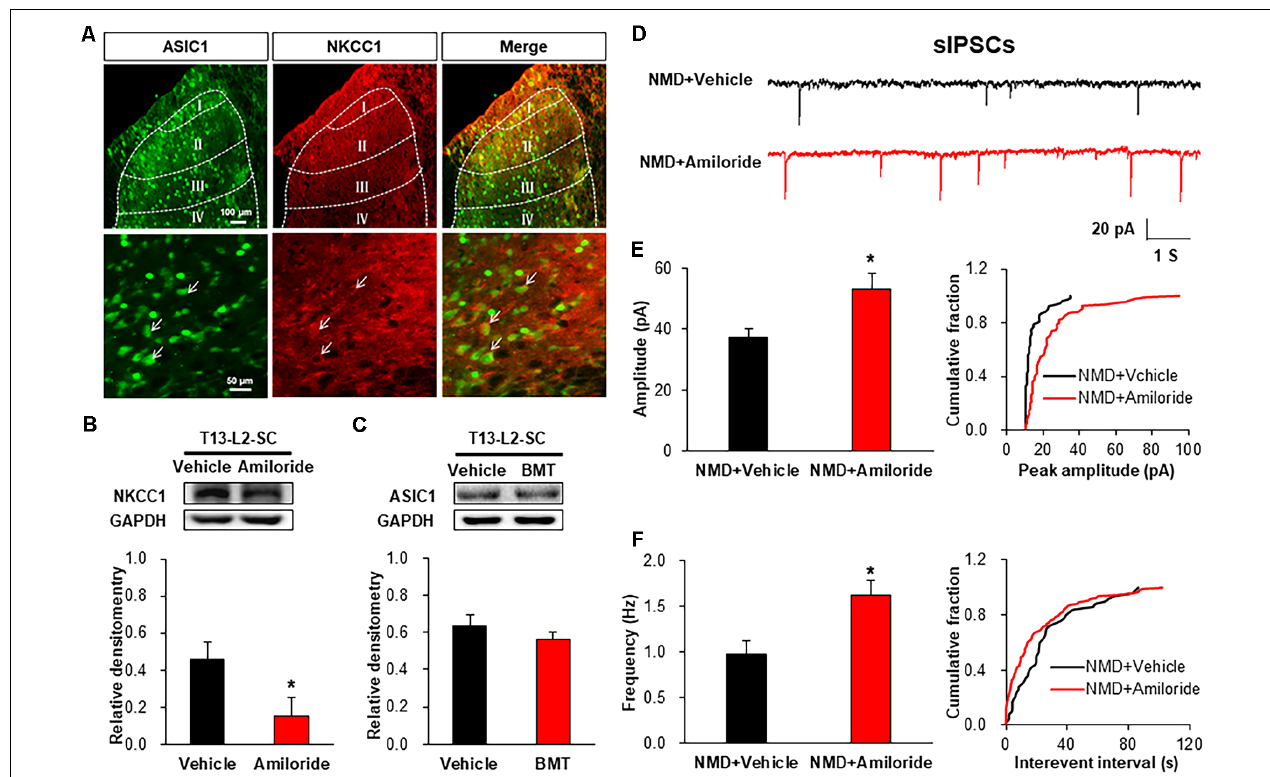
FIGURE 7 | Interaction of ASIC1 and NKCC1. (A) ASIC1 and NKCC1 were co-located in the spinal dorsal horn neurons. (B) Expression of NKCC1 in the spinal dorsal horn after intrathecal injection of Amiloride in NMD rats (* P < 0.05, n = 6 rats for NMD + DMSO group and n = 5 rats for NMD+Amiloride group, two-sample t -test). (C) Expression of ASIC1 in the spinal dorsal horn after intrathecal injection of BMT in NMD rats ( P > 0.05, n = 4 rats for each group, two-sample t -test). (D) Representative traces of sIPSCs recorded in spinal dorsal horn neurons of NMD rats after injection of Amiloride and DMSO. (E) Bar plots and cumulative probability distributions of the amplitude of sIPSCs recorded in spinal dorsal horn neurons of NMD rats after injection of Amiloride and DMSO (* P < 0.05, n = 6 cells for NMD + DMSO group and n = 7 cells for NMD+Amiloride group, two-sample t -test). (F) Bar plots and cumulative probability distributions of the frequency of sIPSCs recorded in spinal dorsal horn neurons of NMD rats after injection of Amiloride and DMSO (* P < 0.05, n = 6 cells for NMD + DMSO group and n = 7 cells for NMD+Amiloride group, two-sample t